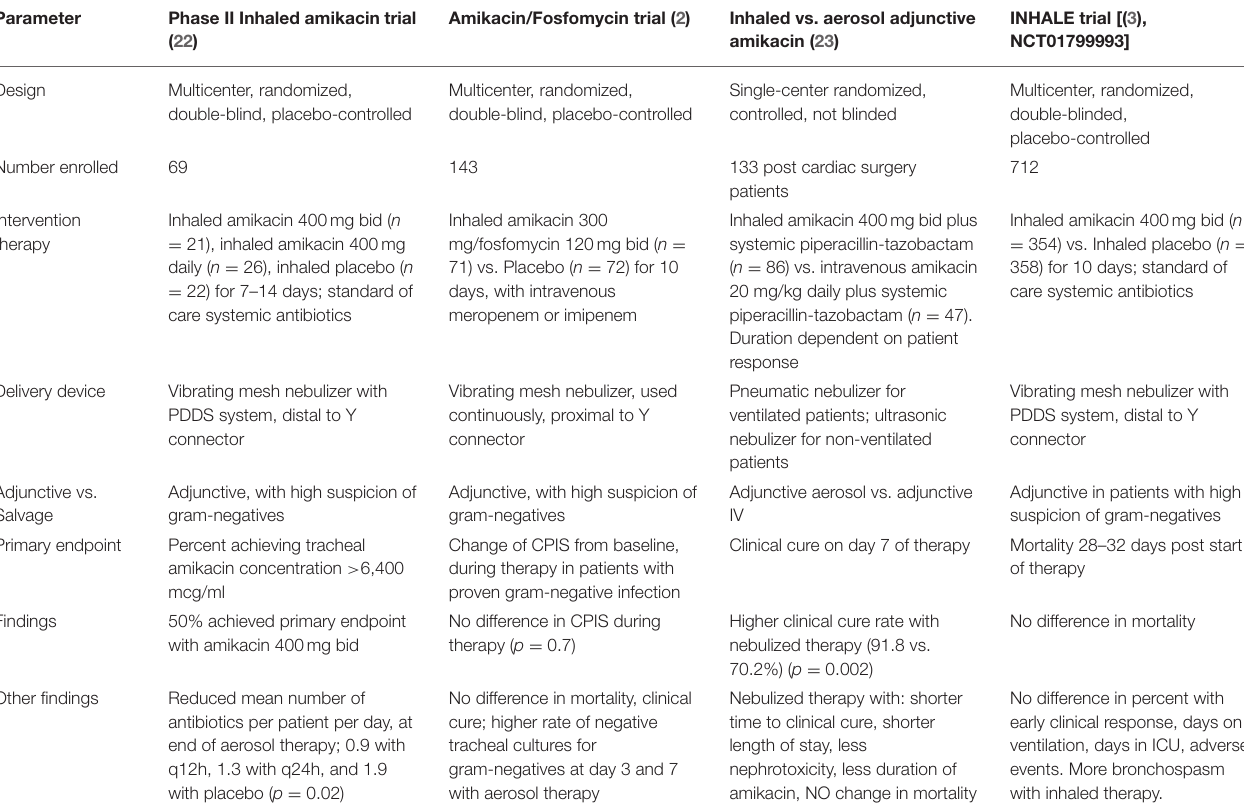
TABLE 2 | New studies of inhaled antibiotics for ICU pneumonia.